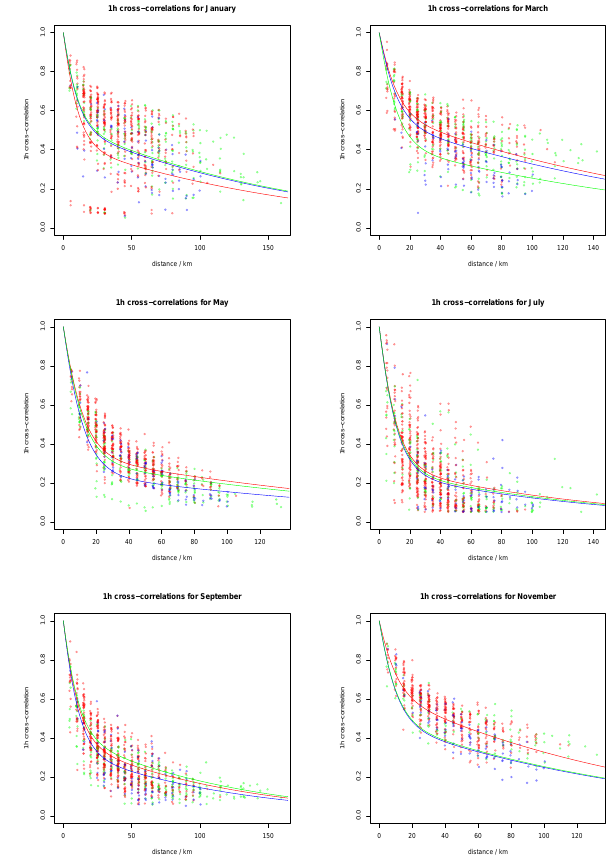
Fig. 4. Fitted (x) and observed (lines) second order properties for the central region (red), southern region (blue) and north-east region (green).